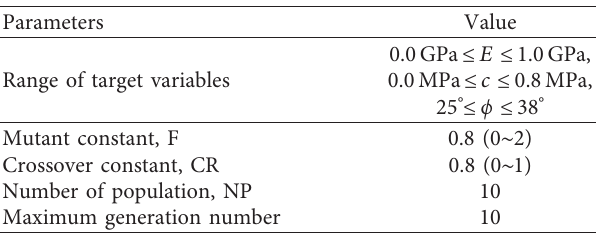
Table 2: DEA properties for back analysis. Parameters